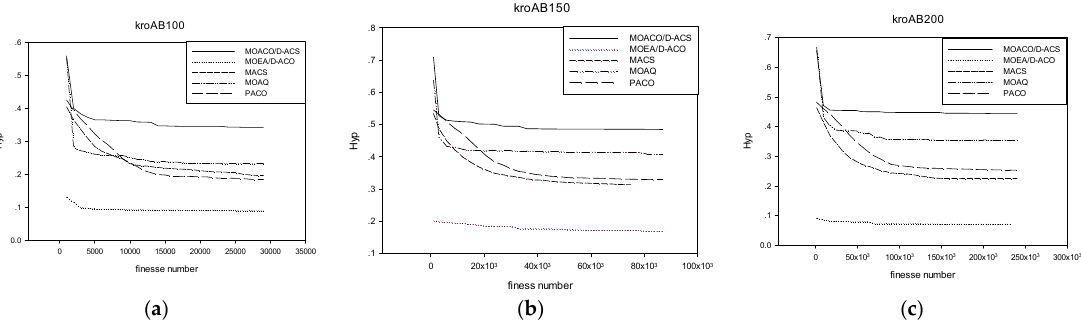
Figure 5. Convergence analysis chart on some test instances shown as ( a ) kroAB100, ( b ) kroAB150 and ( c ) kroAB200.